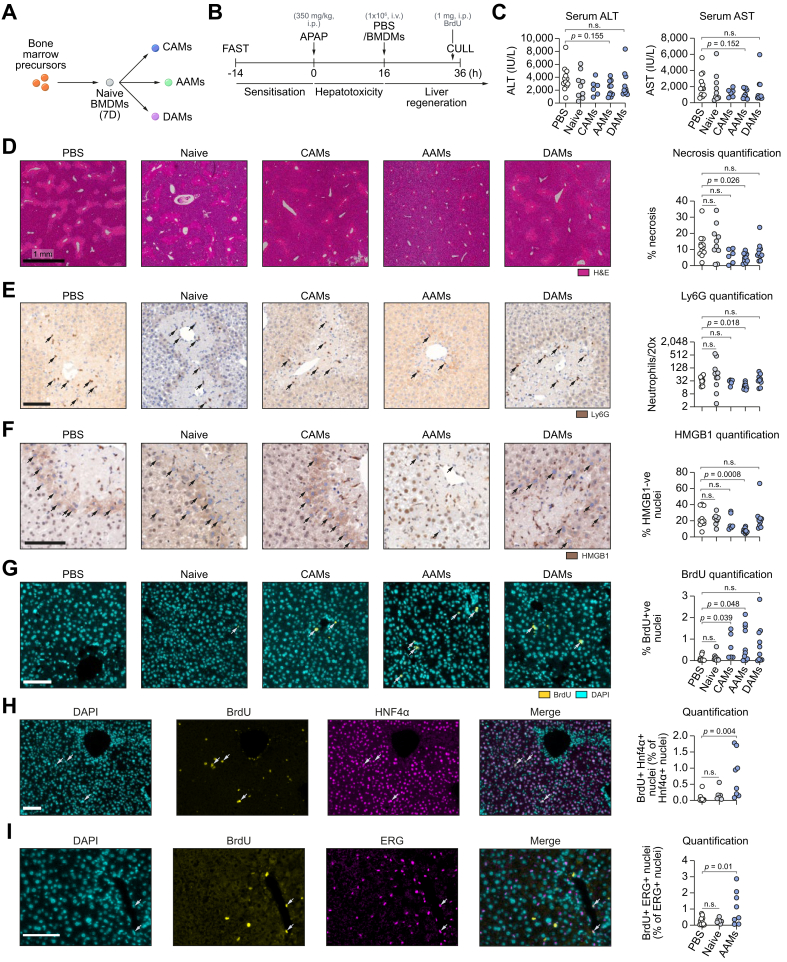
Injection of AAMs reduces necrosis and stimulates liver regeneration following APAP-ALI.(A) Four macrophage populations, derived from mouse BM, were generated for testing: 1. unstimulated BMDMs (naïve), 2. CAMs, 3. AAMs, and 4. DAMs. (B) Study design: injection of macrophages (1 × 106, i.v.) or PBS alone into APAP-ALI mice at 16 h, before cull at 36 h. (C) Serum ALT activity (left panel) and AST activity (right panel) in APAP-ALI mice receiving indicated treatments (D) Representative liver histological stains from APAP-ALI mice receiving indicated treatments, necrosis quantification in right panel (E) Representative Ly6G immunohistochemical stains in liver from APAP-ALI mice with indicated treatments. Black arrows indicate Ly6G-positive cells, quantification in right panel. (F) Representative images of HMGB1 immunohistochemical stains of liver tissue from APAP-ALI mice with indicated treatments. Black arrows indicate HMGB1-negative nuclei, quantification in right panel. (G) Representative immunofluorescence stains of BrdU incorporation (yellow nuclei, indicated by white arrows) in liver with DAPI counterstain (cyan) from APAP-ALI mice with indicated treatments. Quantification in right panel. (H/I) Dual immunofluorescence stains of BrdU (yellow), and either HNF4α (H) or ERG (I) (magenta), with DAPI counterstain (cyan) in AAM-treated liver tissue. White arrows indicate dual-positive cells, quantification in right panel. All data shown are n = 6–12 mice per group (white circles — individual vehicle controls; grey circles — cell-transfer reference group; blue circles — polarised-BMDM-treated mice). Scale bars — 100 μm unless otherwise indicated. p values indicated in panels, Kruskal-Wallis test for (C/D/E/F/G/H). n.s., not significant. One-way ANOVA for I. AAMs, alternatively activated macrophages; ALI, acute liver injury; ALT, alanine aminotransferase; APAP, acetaminophen; APAP-ALI, APAP-induced ALI; AST, aspartate aminotransferase; BM, bone marrow; BMDMs, bone marrow-derived macrophages; CAMs, classically activated macrophages; DAMs, deactivated macrophages.